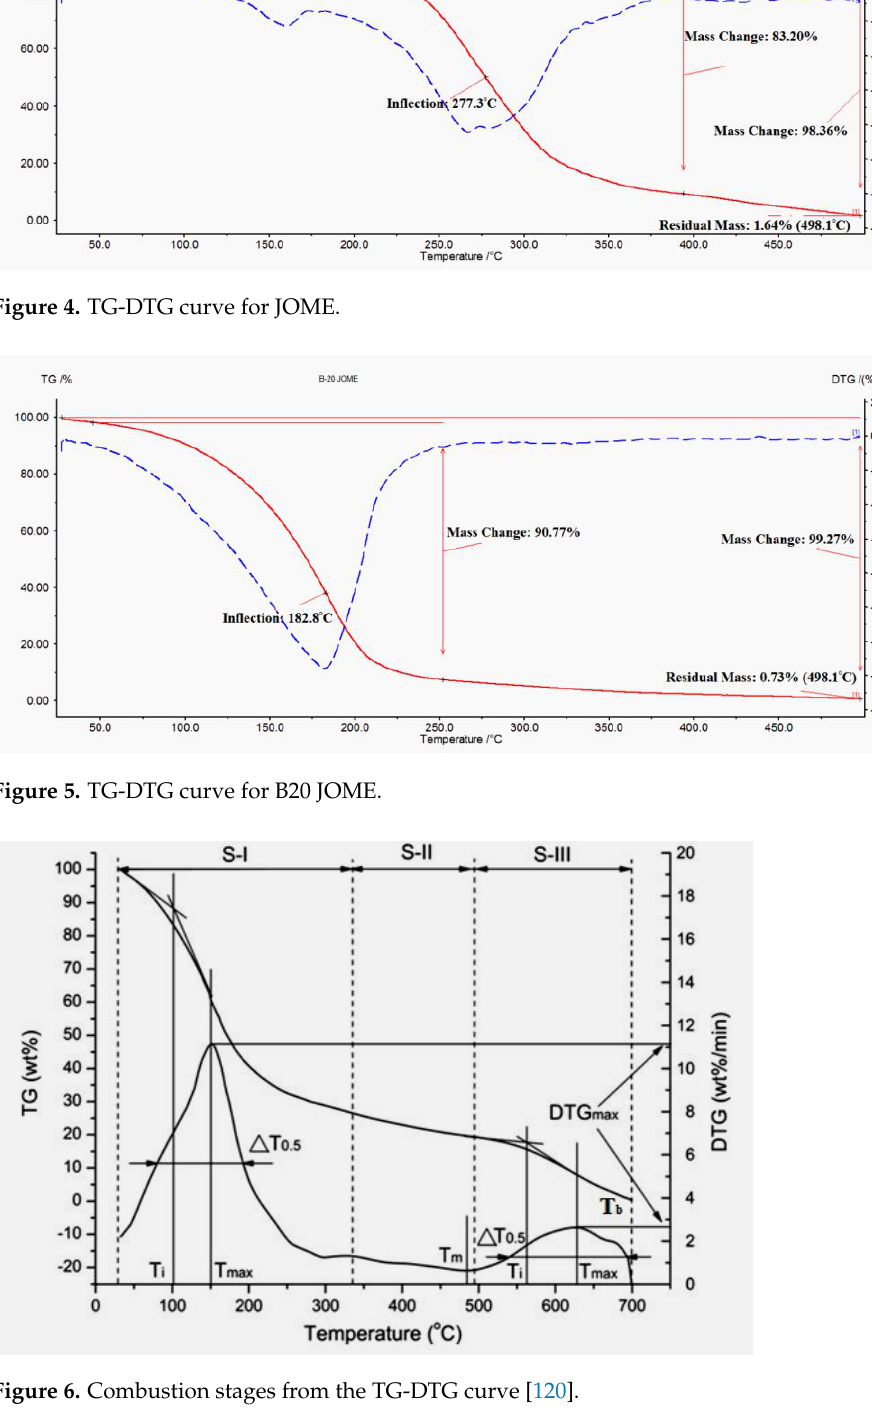
Table 6. Ignition, burnout temperature, DTGmax, and Tmax of diesel, JOME, and B20 JOME. Sample 181.965 Table 7. Combustion characteristics of diesel, JOME, and B20 JOME. Sample